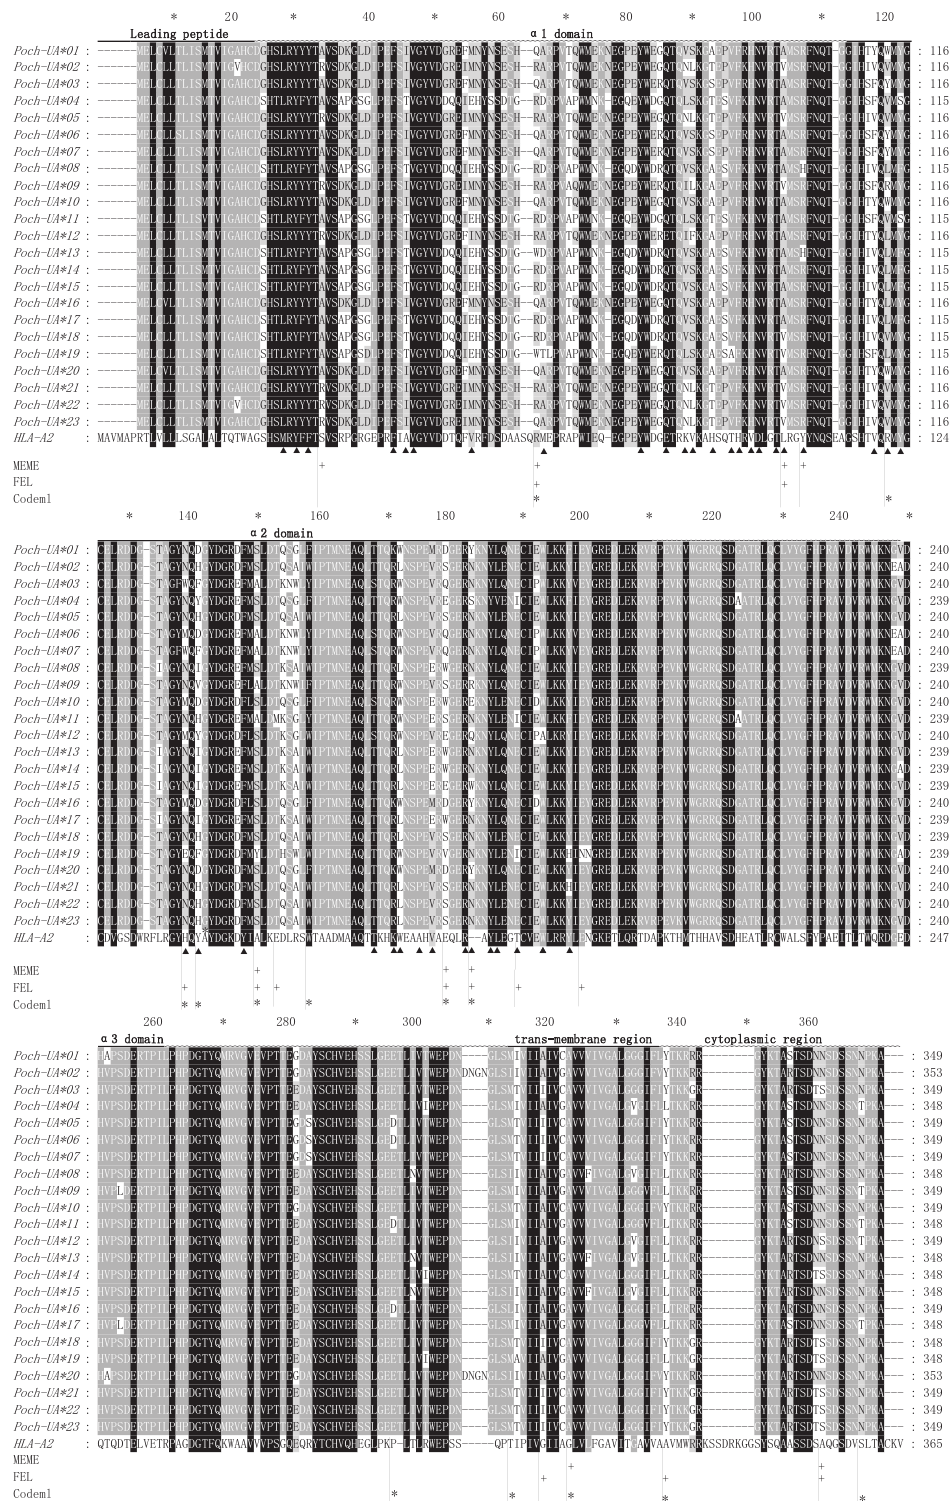
Figure 2. Alignments of amino acid sequences translated from the 23 MHC class I alleles. Sites marked by black triangle represent the putative ABS deduced from structural information from human HLA molecules. The predicted positive selection sites were marked by the short vertical line. * refer to amino acids predicted to be under positive selection in the M8 model of PAML, with posterior probabilities of > 95%. + marks positively selected sites identified by FEL and